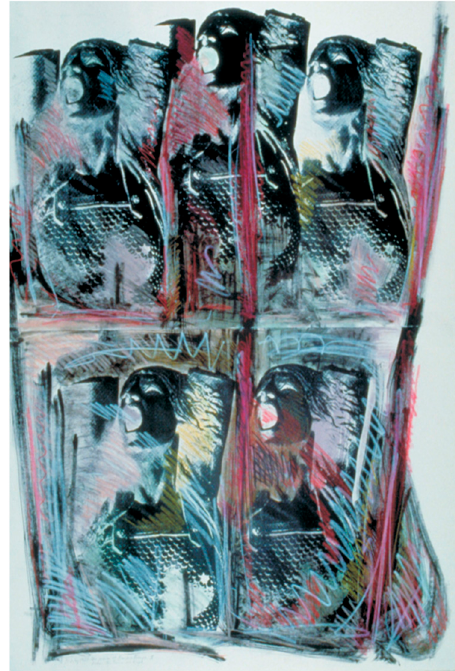
Figure 6. Josely Carvalho, The Rape of Emmatroupe , 1981. Silkscreen and crayons on paper, 51 ½ × 31 ½ inches. Courtesy of the artist. Image credit: Sarah Welss, used by permission. inches. Courtesy of the artist. Image credit: Sarah Welss, used by